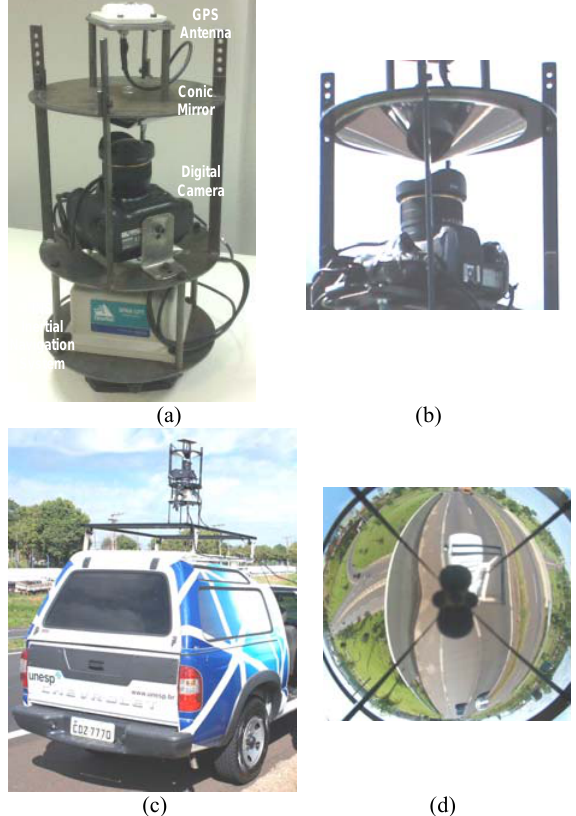
Figure 2: a) Catadioptric system; b) side view of the cone- shaped mirror; c) Mobile System and, d) example of an image acquired over a road. A ratio of 2D Polynomials, relating planimetric coordinates of points in the object space and image columns and rows ( c n r n